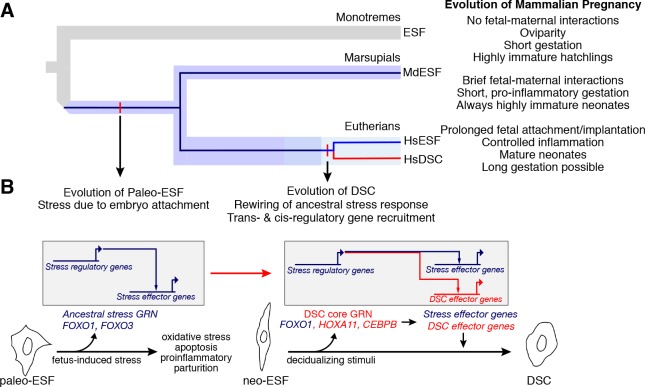
The eutherian mammal decidual cell type evolved from a cellular stress response.(A) Phylogeny showing the three major mammalian clades. Embedded in the species tree, the cell type tree for ESF and DSC cell types is drawn. Paleo-ESF is an ancestral cell type to crown group neo-ESF, such as human HsESF, which arose after the split of metatherian (marsupials) and eutherian (placental) mammals. The eutherian neo-ESF is defined by its ability to differentiate into DSC, which is the sister cell type to eutherian neo-ESF. (B) Proposed model of the evolution of eutherian DSC from a paleo-ESF ancestral cell type. Paleo-ESF underwent a stress response during the short gestational period in which fetal–maternal interactions lead the proinflammatory, stress-induced parturition seen in crown marsupials. The ancestral stem eutherian rewired the stress-related regulatory modules to stabilize an alternative gene regulatory state and control the expression of effector genes, which allow fetal implantation and invasive placentation, long gestation, and anti-inflammatory phenotypes typical of crown eutherian mammals. DSC, decidual stromal cell; ESF, endometrial stromal fibroblast; HsESF, human endometrial stromal fibroblast.